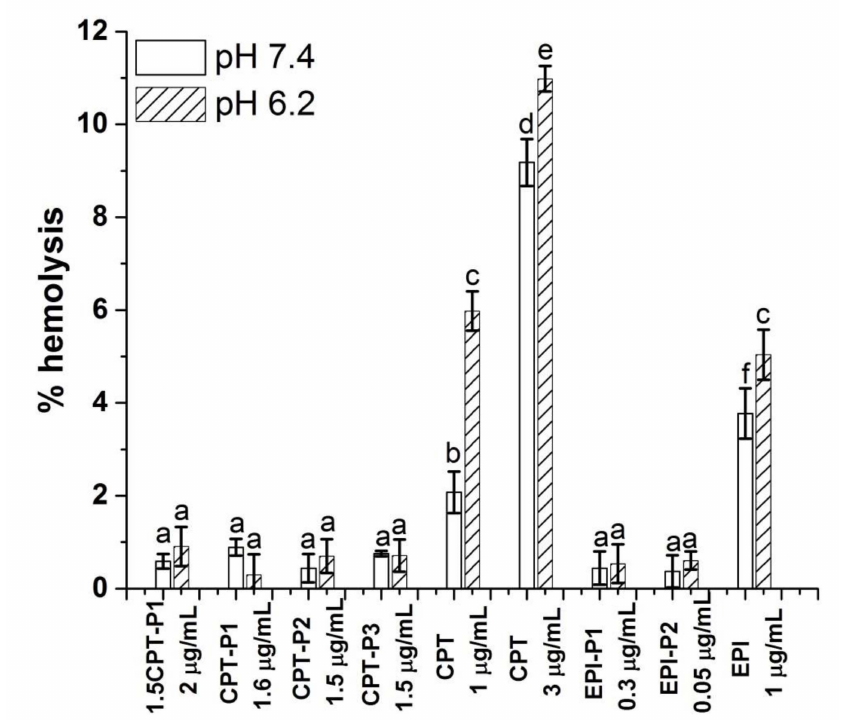
Figure 7. Percentage of hemolysis of RBC treated with CPT- and EPI-loaded polyphosphazene nanoaggregates, parent CPT and EPI in PBS at pH 7.4 and 6.2 (see structures in Figure 1).